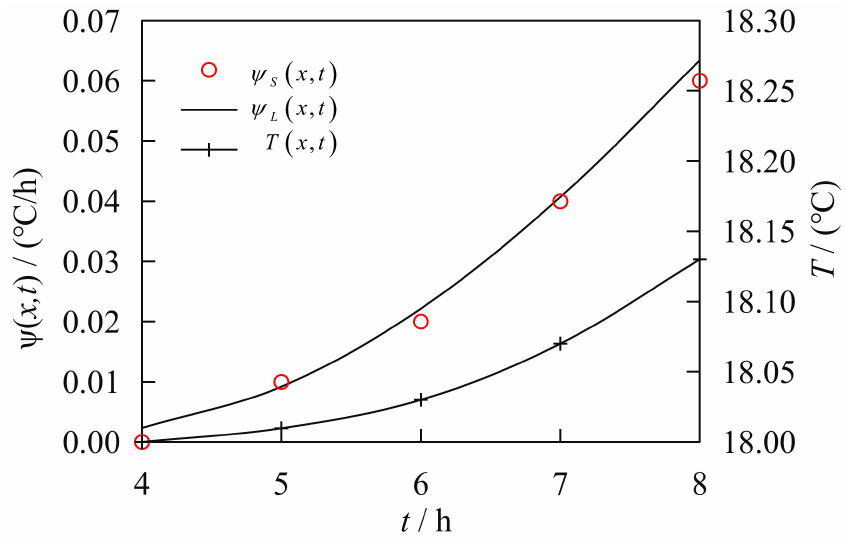
Figure 7. Comparison diagram of the measured and theoretical curves of ψ ( x , t ) at x = 0.8 m. Table 6 and Figure 7 show that the relative errors of ψ S ( x , t ) − t and ψ L ( x , t ) − t were small at x = 0.8 m and the fitting curve was also better than that at x = 0.5 m. This